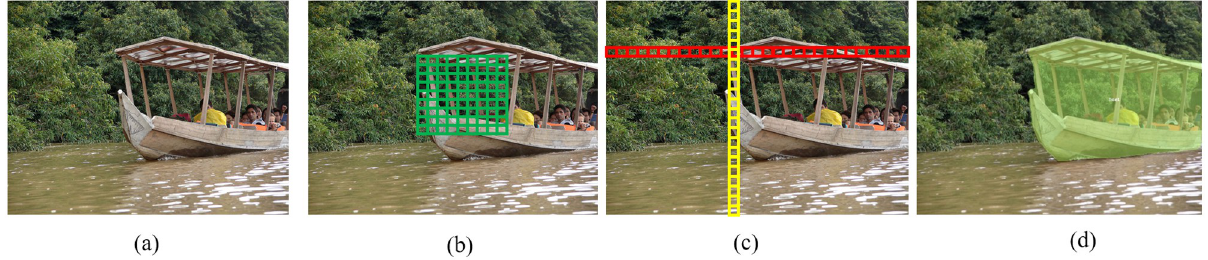
Fig 8. Illustration of the difference between 2D spatial pooling and 1D strip pooling in instance segmentation. (a) The original image. (b) 2-D spatial pooling. (c)1D strip pooling. (d) The segmentation result using the GALA mechanism.